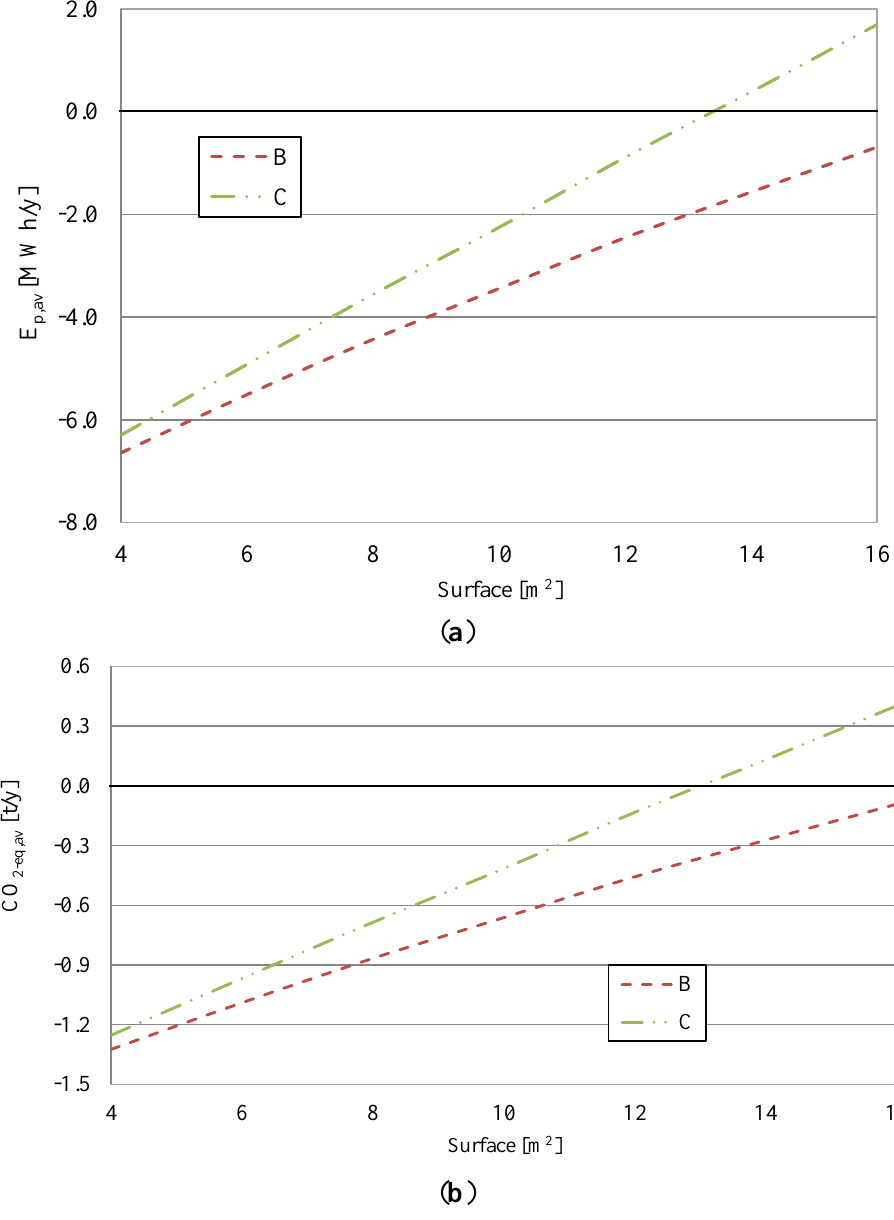
Figure 9. Energy and emissions analysis considering the current Italian situation and excluding DHW demands. ( a ) Avoided primary energy consumption and ( b ) avoided equivalent CO 2 emissions. Scenarios B (flat-plate collectors) and C (evacuated tube